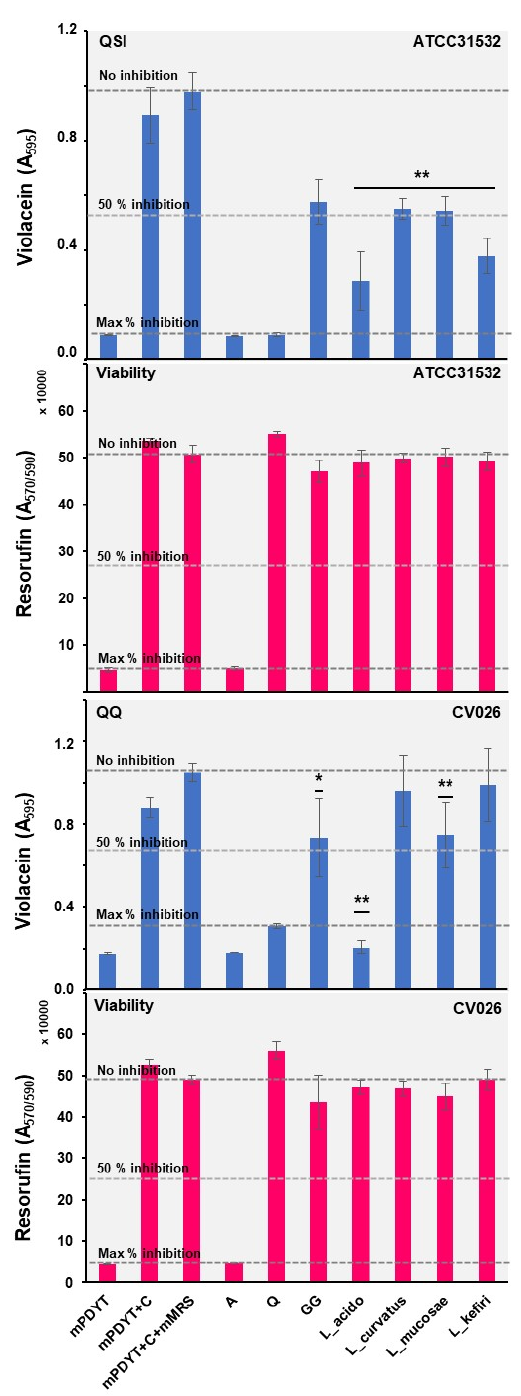
Figure 4. Anti-QS (blue) and bactericidal (pink) activities of the selected samples against ATCC31532 and CV026. mPDYT, growth media; mPDYT+C, growth medium with ATCC31532 or CV026; A, azithromycin; Q, quercetin. Error bars ± SD ( n = 5–6). Changes in violacein synthesis in relation to mPDYT+C+mMRS; * p <0.05; ** p <0.001. Grid lines, detected violacein levels with/without QS (Q) and bactericidal (A) inhibitors.